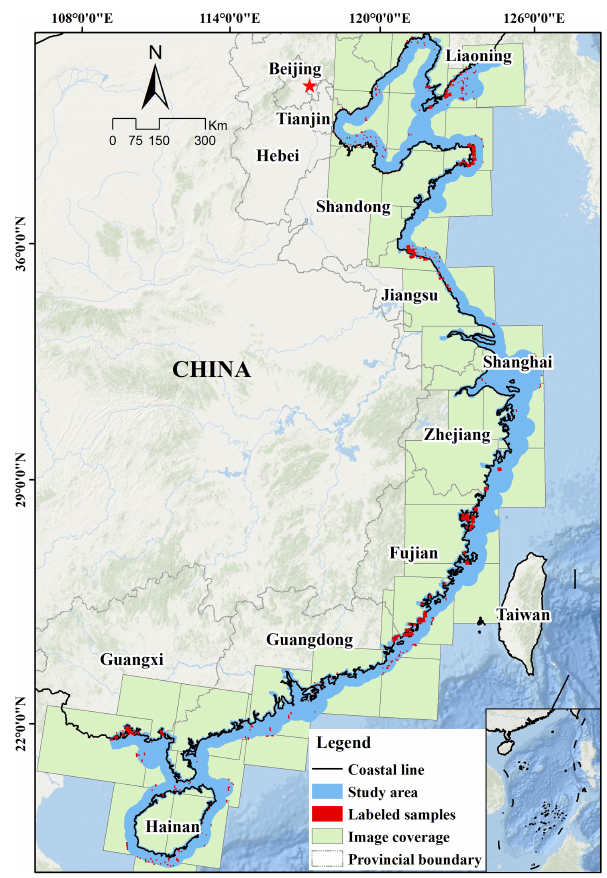
Figure 1. Location of the study area, the spatial distribution of la- beled samples, and acquired GF-1 wide-field-of-view (WFV) image swaths in our